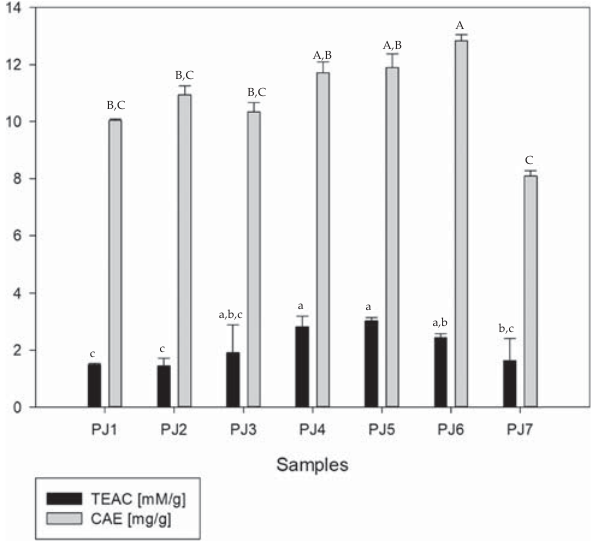
Figure 1: Antioxidant activities and total phenolic contents of ana - lyzed PJ samples ( PJs ) . PJ1: VR 808, PJ2: Saturna, PJ3: Toscana, PJ4: Ditta, PJ5: Lord, PJ6: Denar, and PJ7: Lady Claire. Mean values with di ff erent letters are signi fi cantly di ff erent at α =